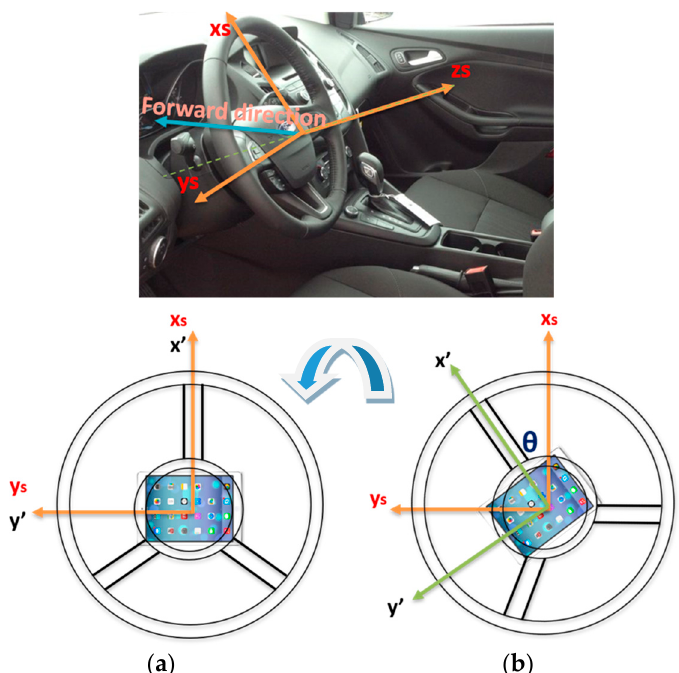
Figure 2. Steering fixed frame and the CPD frame. ( a ) The steering fixed and the CPD frames coincide for a 0° steering angle; ( b ) the steering angle and the CPD frames for steering angle ( θ ).